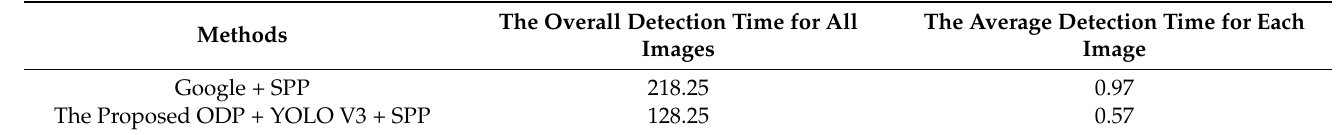
Table 5. Comparing the average detection time between the original classic Google + SPP and the proposed ODP + YOLO V3 + SPP in the seconds for each